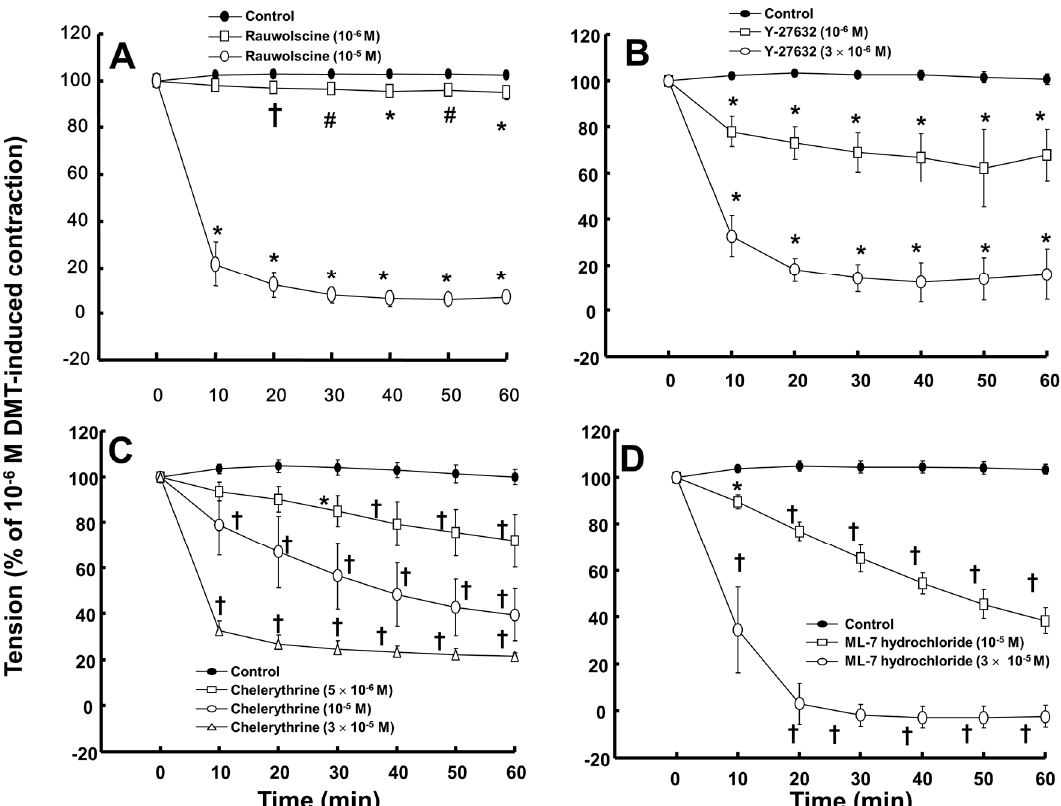
Figure 4. Effect of rauwolscine (( A ), n = 6), Y-27632 (( B ), n = 6), chelerythrine (( C ), n = 6), and ML-7 hydrochloride (( D ), n = 6) on the dexmedetomidine (DMT)-induced contraction in endothelium-denuded aortas. All data are expressed as the mean ± SD and the percentage of the maximal contraction induced by DMT (10 − 6 M). N indicates the number of rats from which descending thoracic aortic rings were derived or the number of isolated rat aortic rings. The effects of each inhibitor (rauwolscine, Y-27632, chelerythrine, and ML-7 hydrochloride) on the DMT concentration-response curves were analyzed using two-way repeated measures analysis of variance followed by Bonferroni’s post hoc test. ( A , B ): † p < 0.05, # p < 0.01, and * p < 0.001 versus control; ( C , D ): * p < 0.01 and † p < 0.001 versus control.